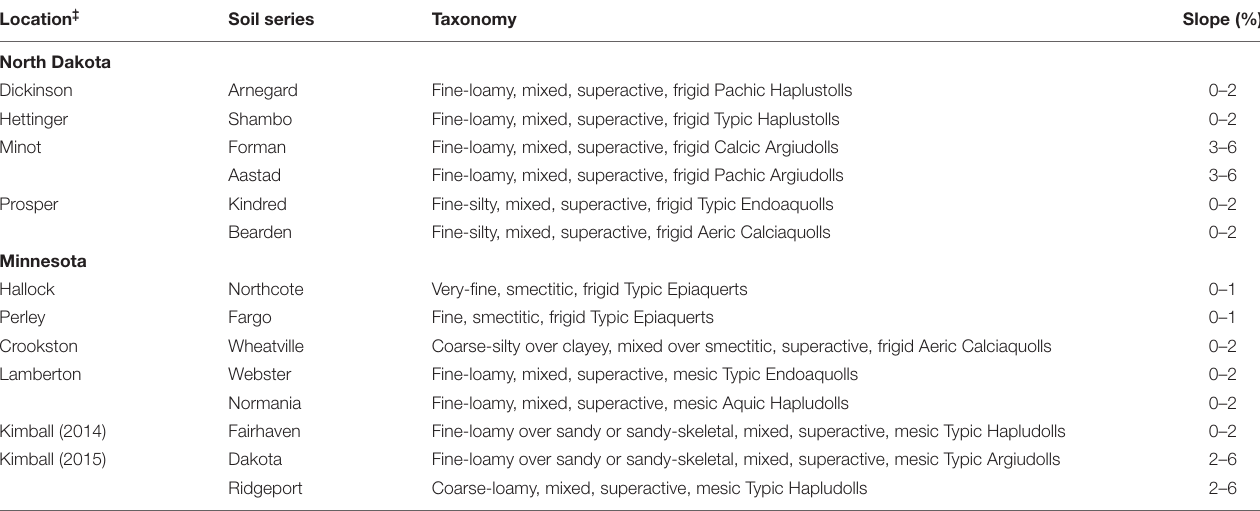
TABLE 1 | Location and soil characteristics † of environments in seeding rate